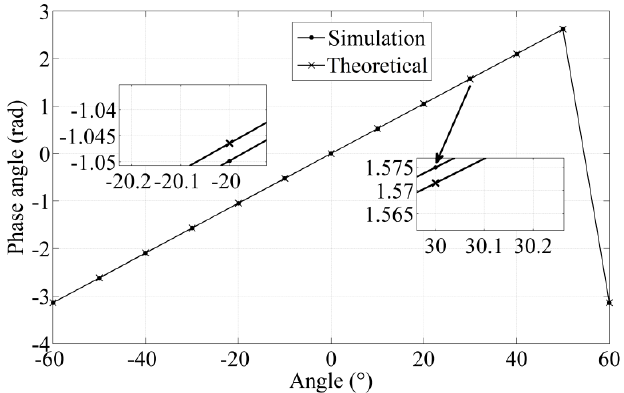
Figure 8. Error of the simulation model in phase angle.